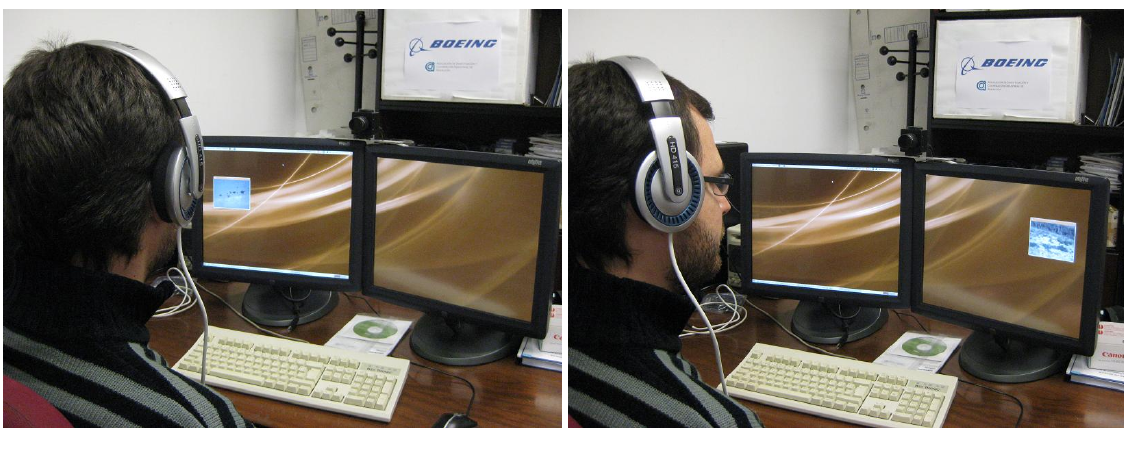
Figure 13. Photographs of the “virtual” head-mounted display in operation when the user looks at left and right